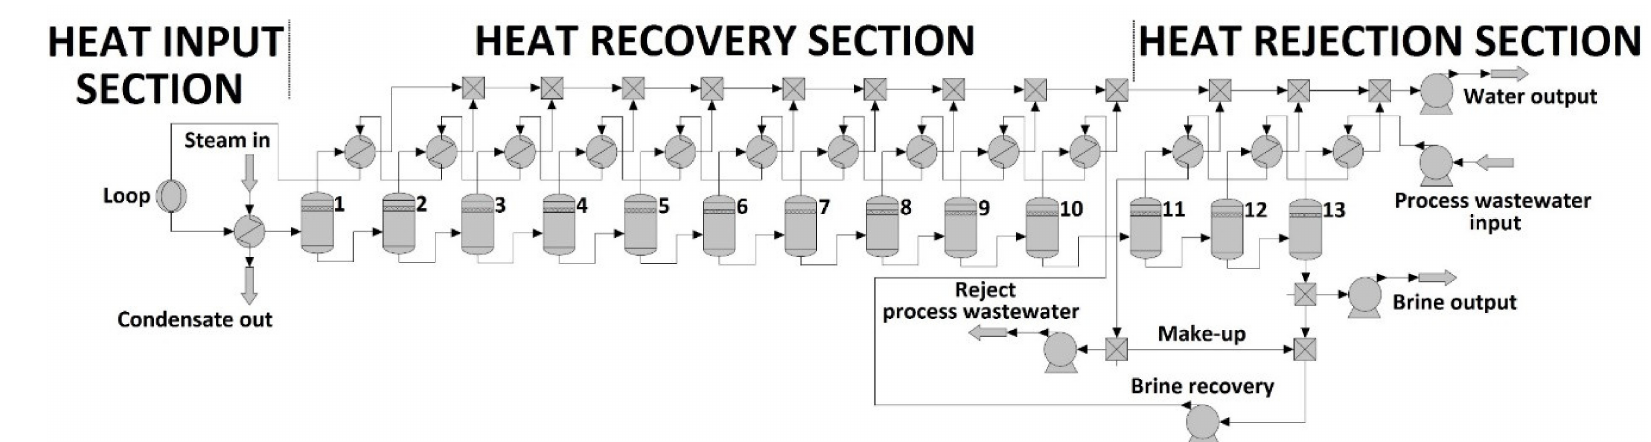
Figure 4. Flowsheet of multi-stage flash distillation method in ChemCAD simulator